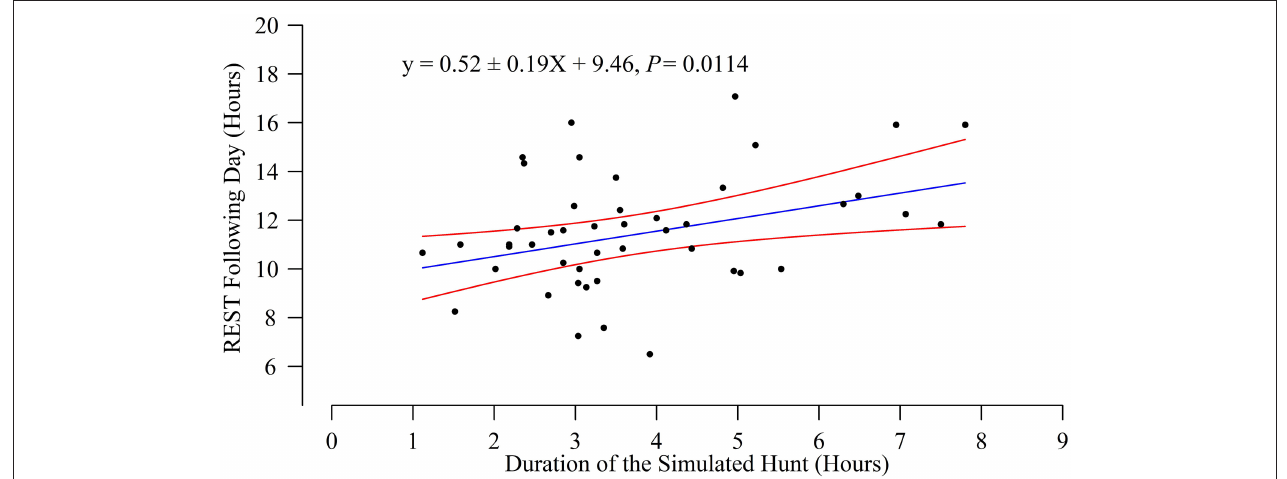
FIGURE 2 | The day after the simulated hunts, female bears rested more if the simulated hunts were longer ( P = 0.0114). The 46 simulated hunts are represented by the black dots with the regression line, as well as the lower and upper 95% confidence interval. The model REST ∼ Duration of the simulated hunt*AGE was fitted with the Bear ID as a random factor. The variable AGE was not kept after using the backward selection method (Interaction: P = 0.34, AGE: P = 0.29).